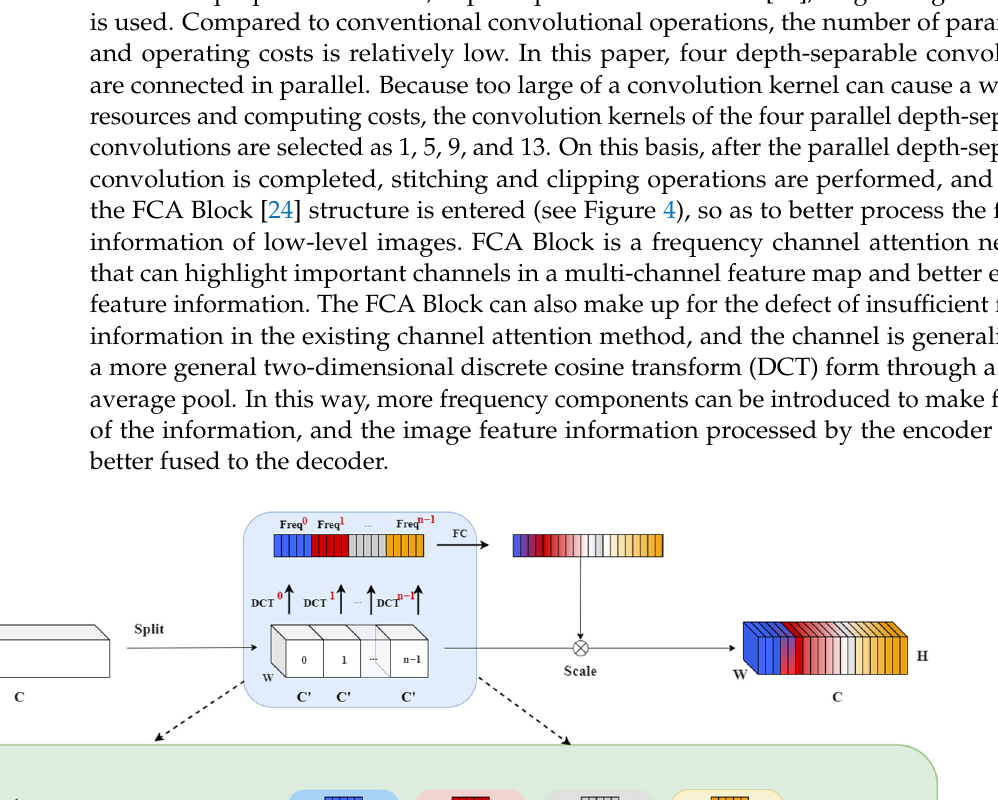
Figure 3. Diagram of the depthwise FCA block structure.